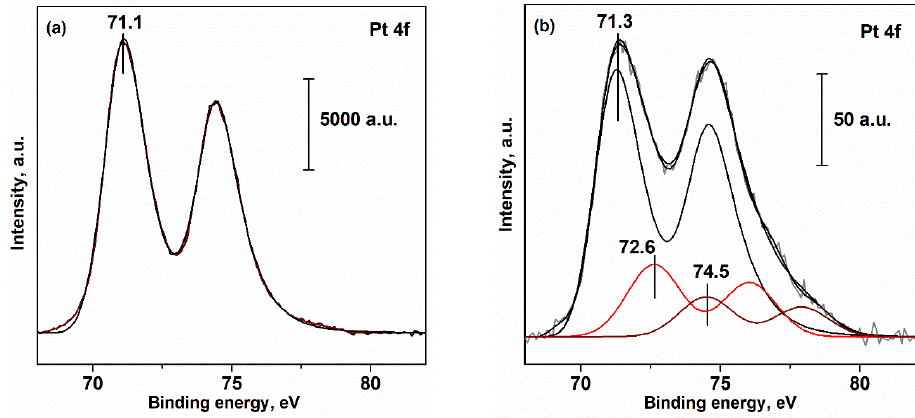
Figure 2. Pt4f spectra of ( a ) Pt foil and ( b ) Pt-C catalyst.